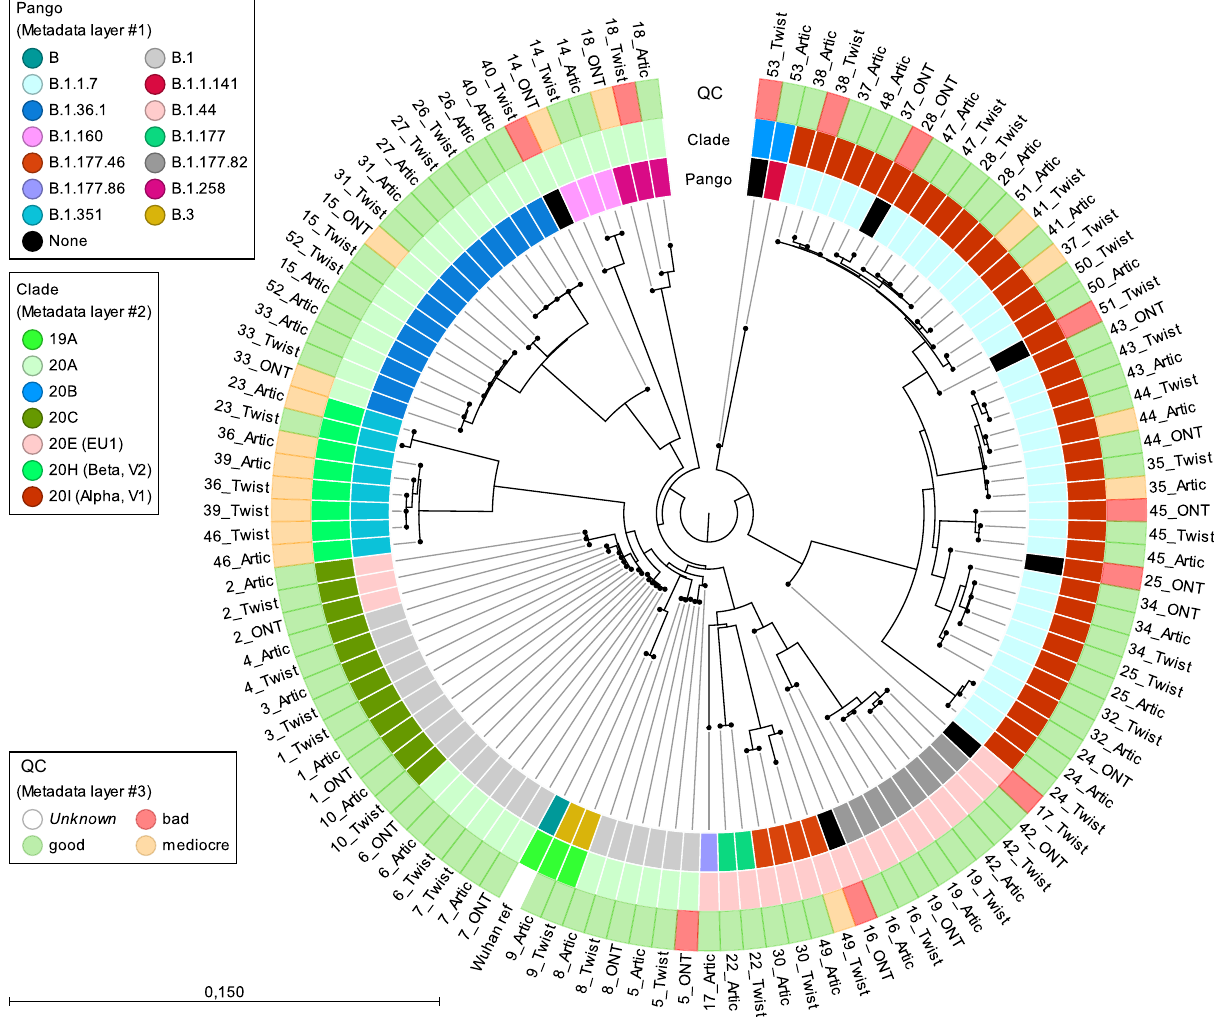
Figure 5. Neighbour joining tree from whole genome comparison of consensus sequences of SARS‑CoV‑2 genomes generated with Twist bait hybridization enrichment and ARTIC V3 tiled amplicon enrichment on Illumina as well as Midnight tiled amplicon enrichment on Oxford Nanopore Technologies (ONT). Pangolin lineage (Pango), Nextclade (Clade) and Nextclade quality control (QC) measures to flag potential problematic sequences, shown in